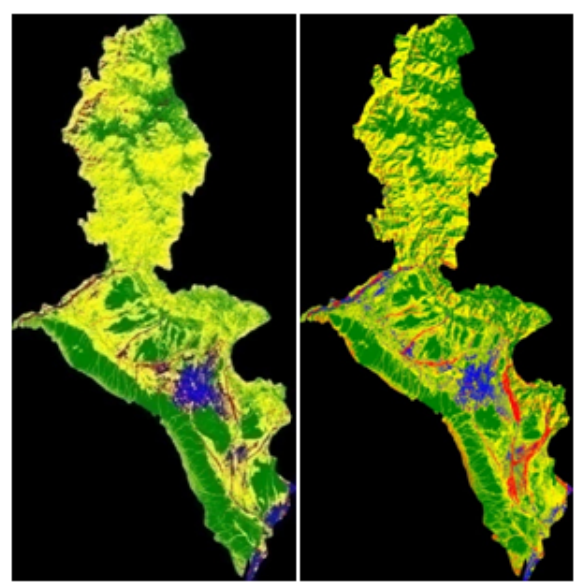
Figure 3: Collection of output Data generated by Sentinel-2 and LANDSAT-8 at resolution 30m by CART